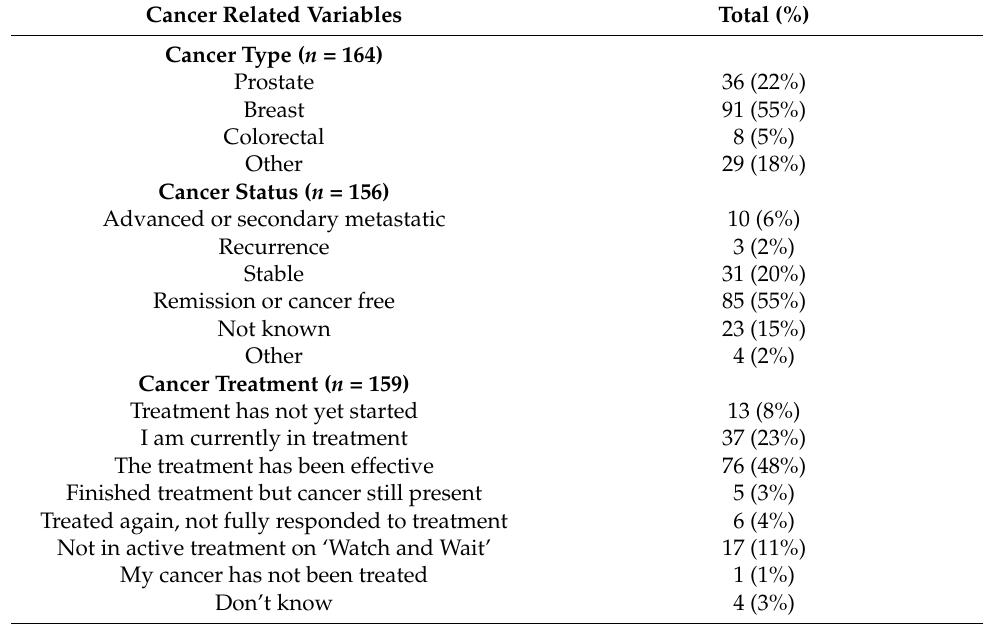
Table 3. The number (%) of participants by cancer type, cancer status and treatment status at baseline. Cancer Related Variables